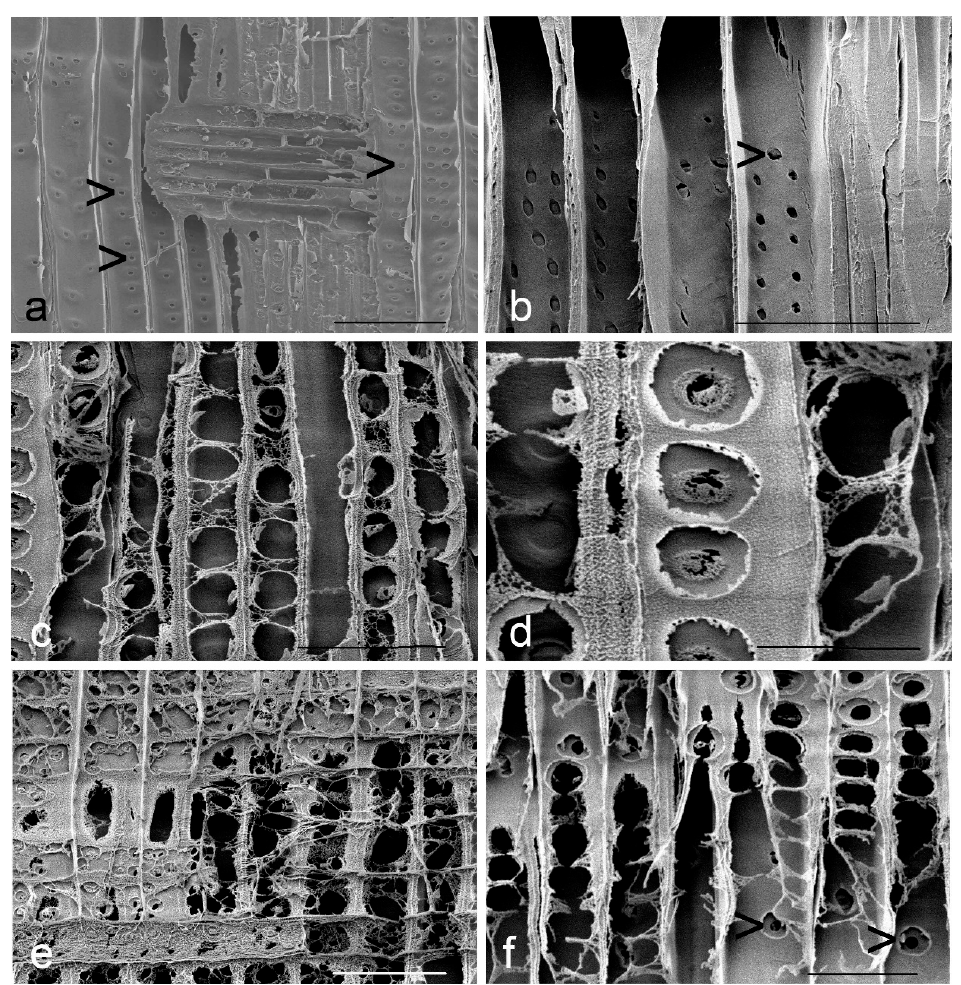
Figure 6. Scanning electron microscopy images of unmodified and plasma-modified black spruce samples: ( a ) Untreated sample showing intact bordered and half-bordered pits (arrowed), scale bar = 100 µm; ( b ) sample treated with plasma for 180 s showing rupture of half-bordered pit membranes (arrowed right), scale bar = 50 µm; ( c ) surface treated with plasma for 600 s showing etching of bordered pits at tracheid surfaces, scale bar = 50 µm; ( d ) sample treated with plasma for 600 s showing etching of the raised dome and membrane in bordered pits, scale bar = 25 µm; ( e ) sample treated with plasma for 1200 s showing etching of rays and bordered pits, scale bar = 50 µm; and ( f ) sample treated with plasma for 1200 s showing etching of bordered pits at tracheid surface and in underlying tracheids (arrowed bottom right), scale bar = 50 µm.